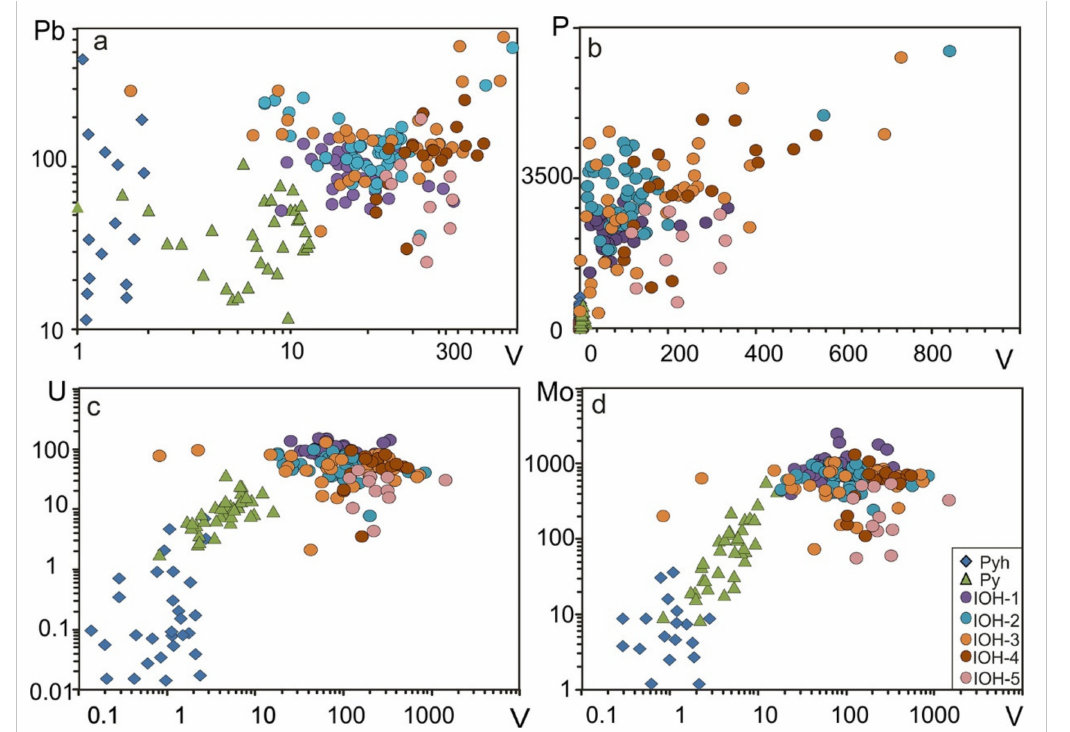
Figure 9. Bivariate plots of: ( a ) V vs. Pb; ( b ) V vs. P; ( c ) V vs. U and ( d ) V vs. Mo for the iron oxyhydroxides (IOH), pyrite (Py) and pyrrhotite (Pyh) of the Pobeda-1 hydrothermal field